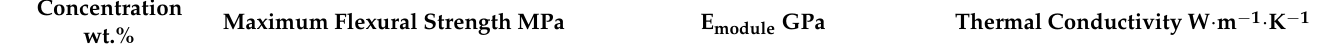
Table 3. Mechanical and thermal properties of PSU-based composites filled AG, NG and EG. Concentration